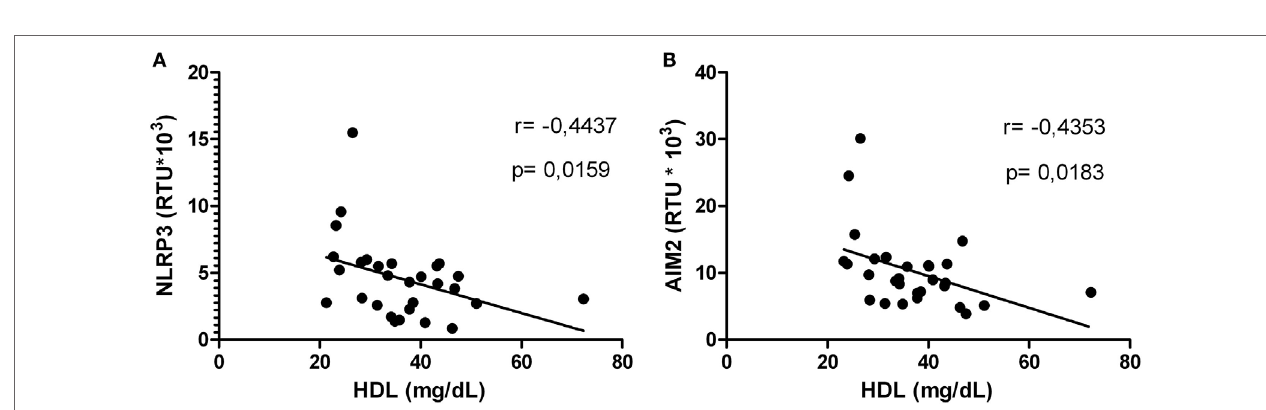
FigUre 5 | High-density lipoprotein (HDL) level correlated with NLRP3 or AIM2 in human immunodeficiency virus type 1-infected individuals. Correlation between HDL and NLRP3 (a) or AIM2 (b) was performed using a Spearman test. The r and p values are indicated in each figure. A p value lower than 0.05 was considered as significant.